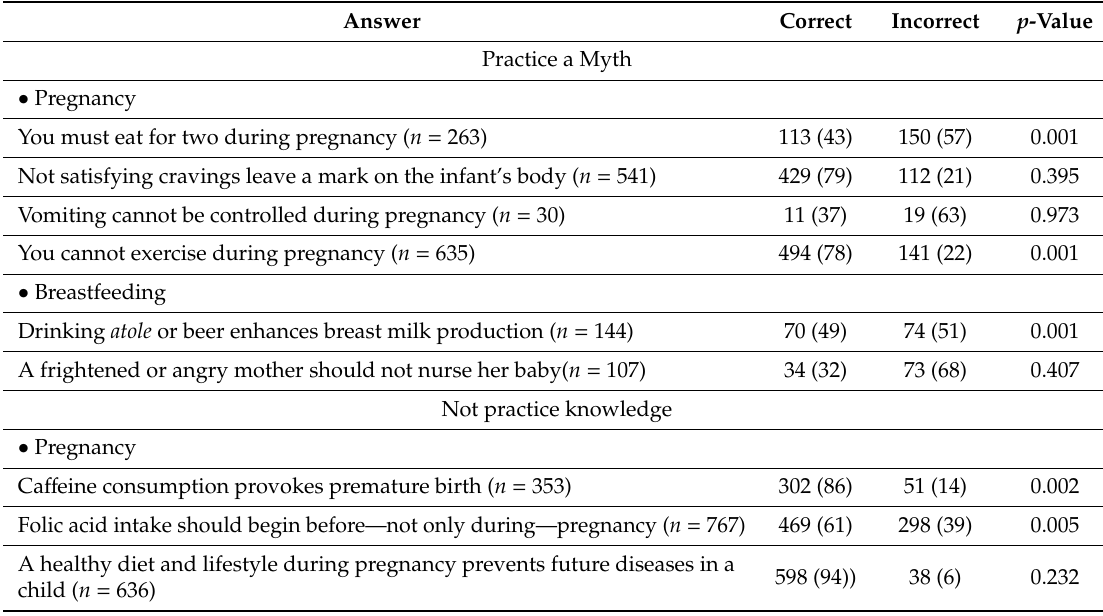
Table 5. Distribution of questionnaire responses by women who practice myths and do not act on scientific knowledge, frequency